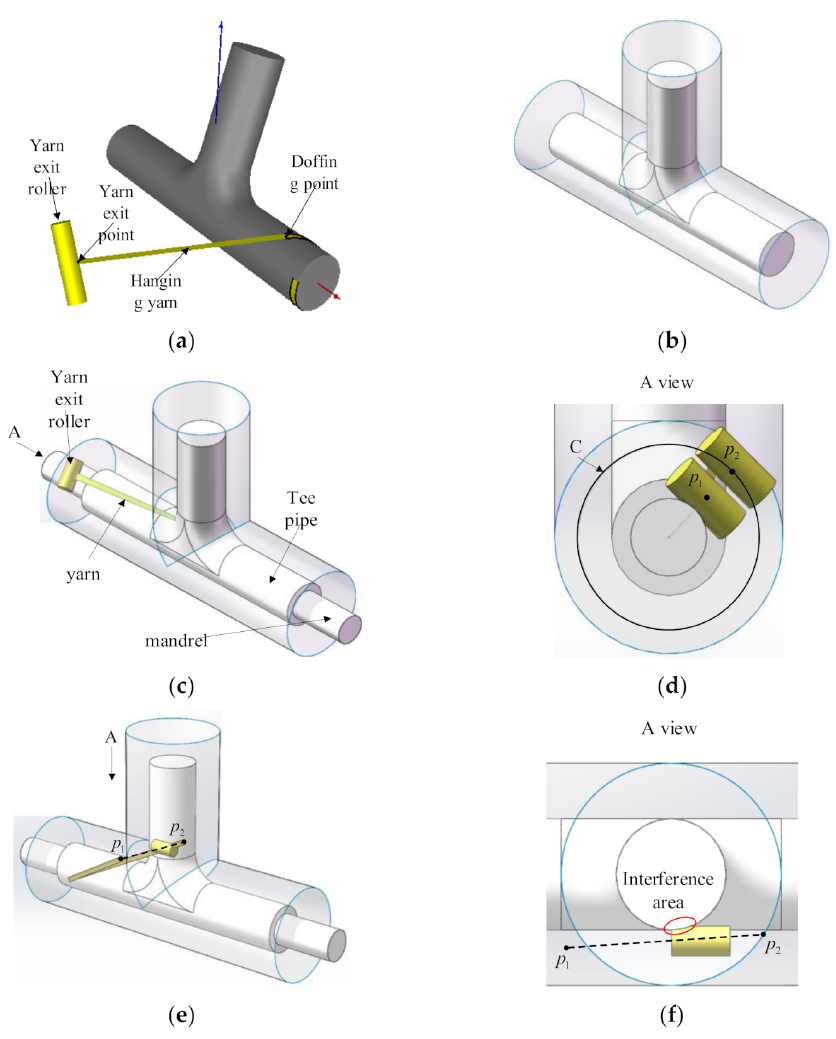
Figure 7. Schematics of interferences: ( a ) Schematic diagram of winding concept; ( b ) Envelop surface intersects directly; ( c ) Mandrel interferences; ( d ) Yarn exit offset; ( e ) Interference in the linear interpolation process; ( f ) Interference